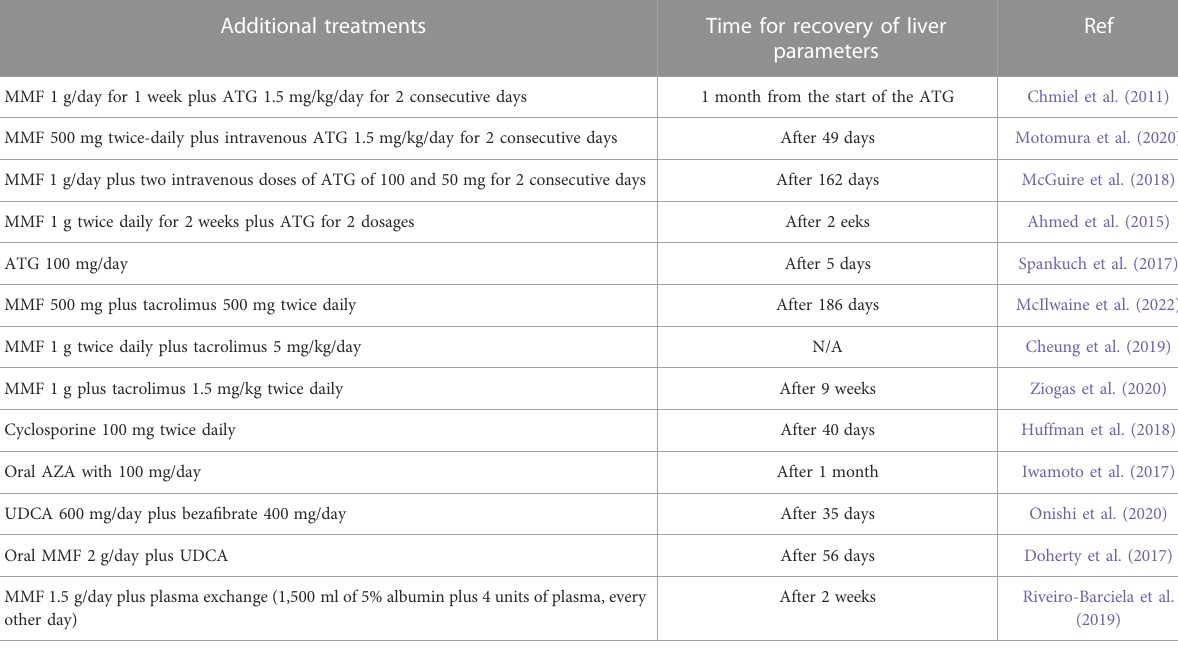
TABLE 5 Additional treatments for steroids-refractory immune-mediated hepatitis from case reports. Additional